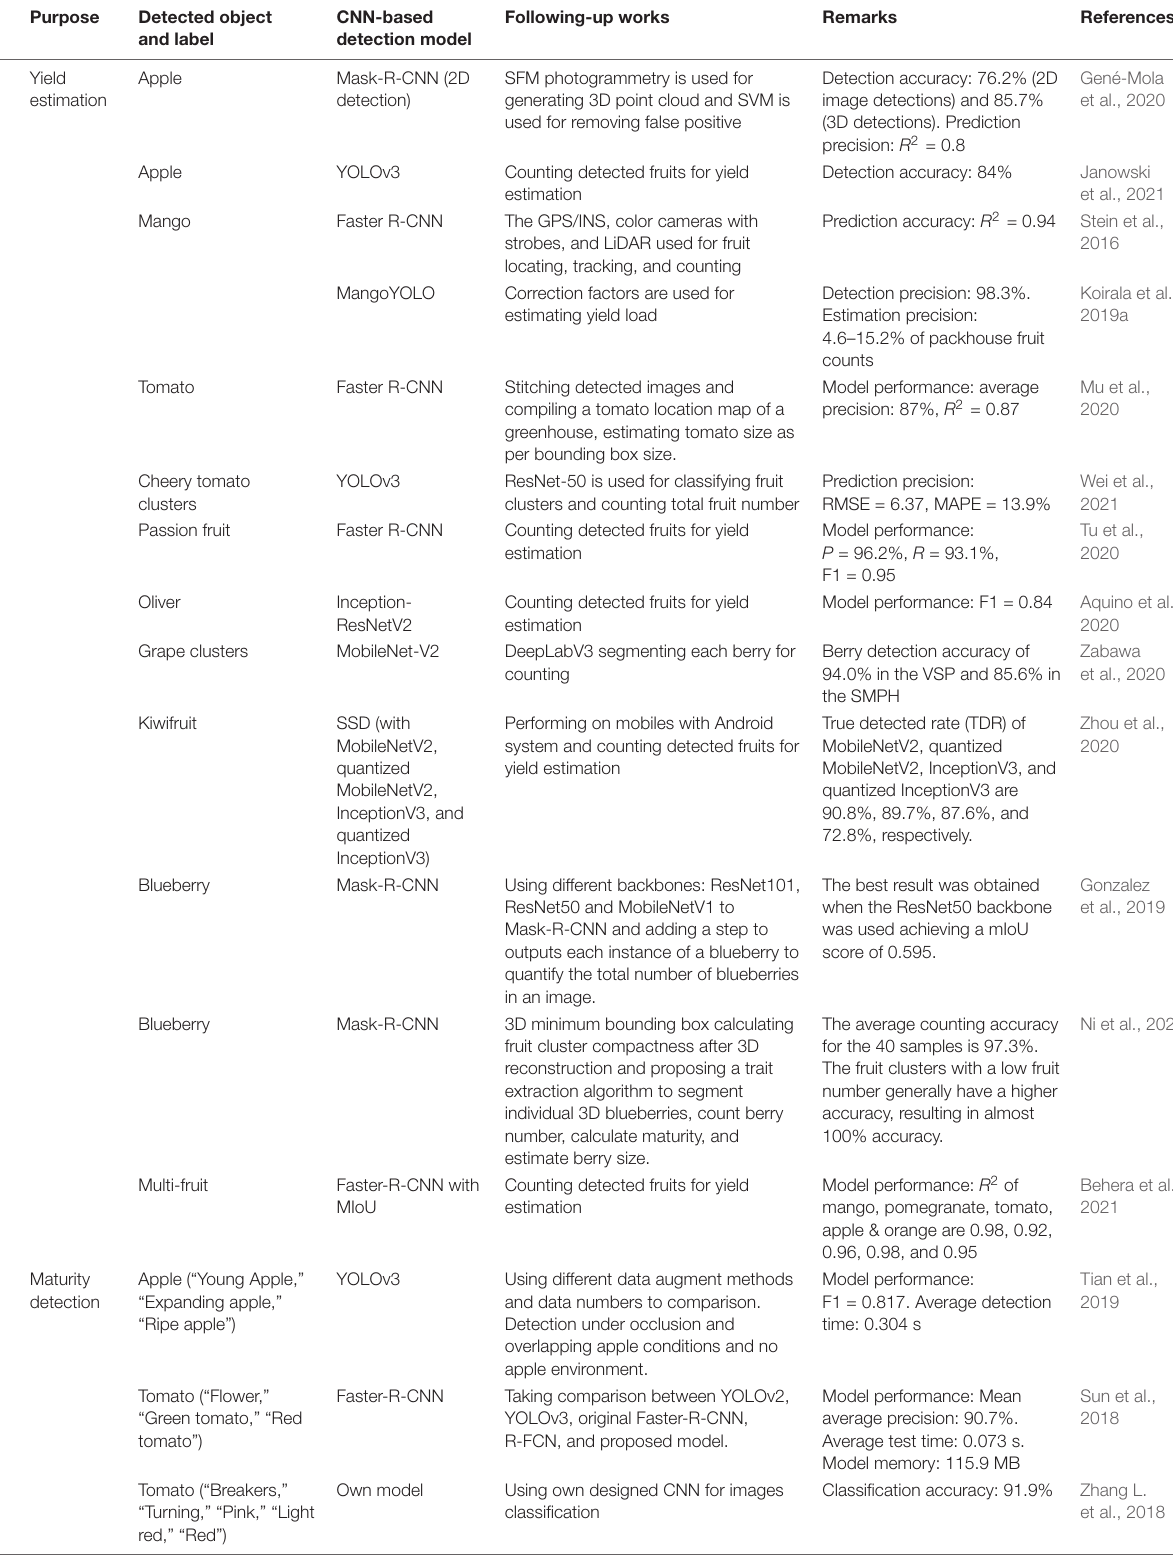
TABLE 5 | Summary of related studies on application of CNN-based detection models in growing